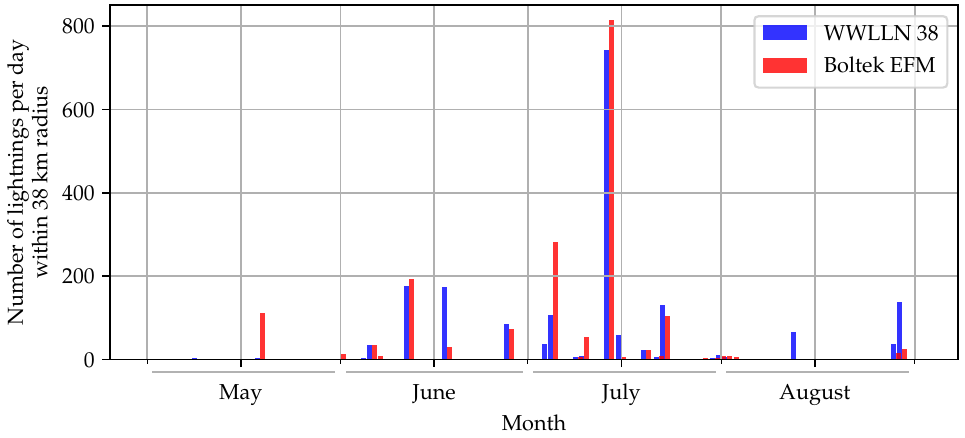
Figure 4. The number of discharges detected by the WWLLN and Boltek